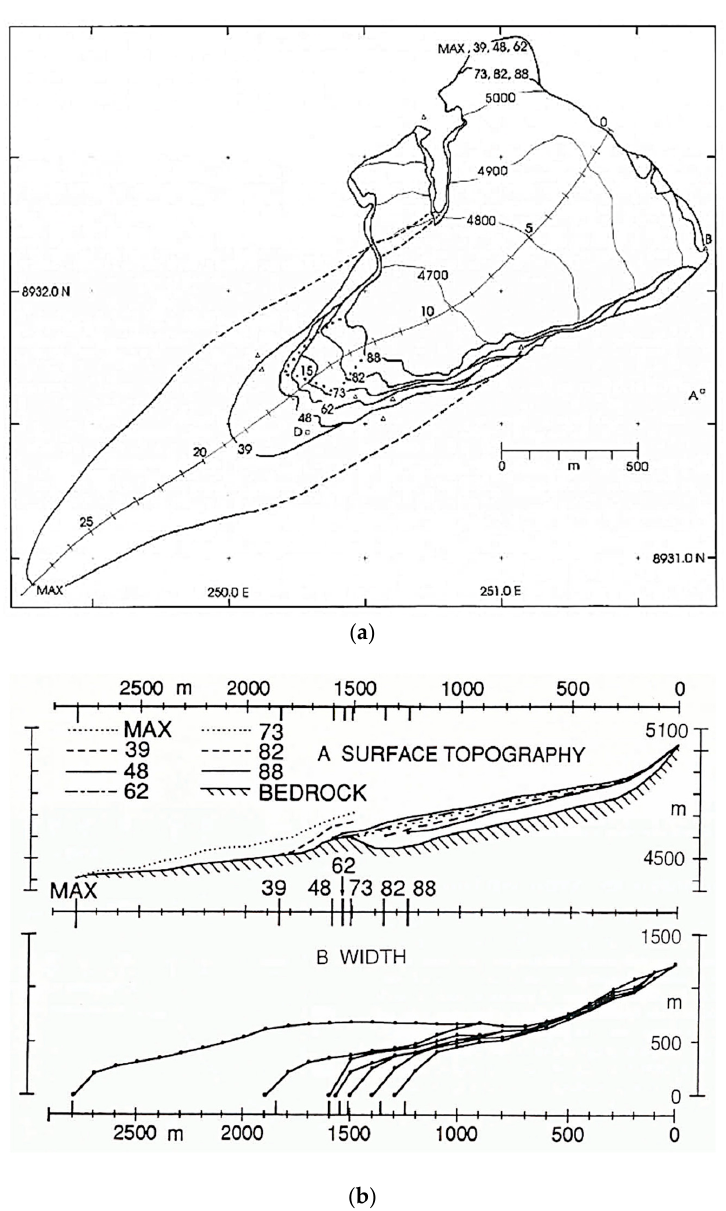
Figure 4. Surveyed data of the Yanamarey glacier [56]. ( a ) The ice extent of the Yanamarey